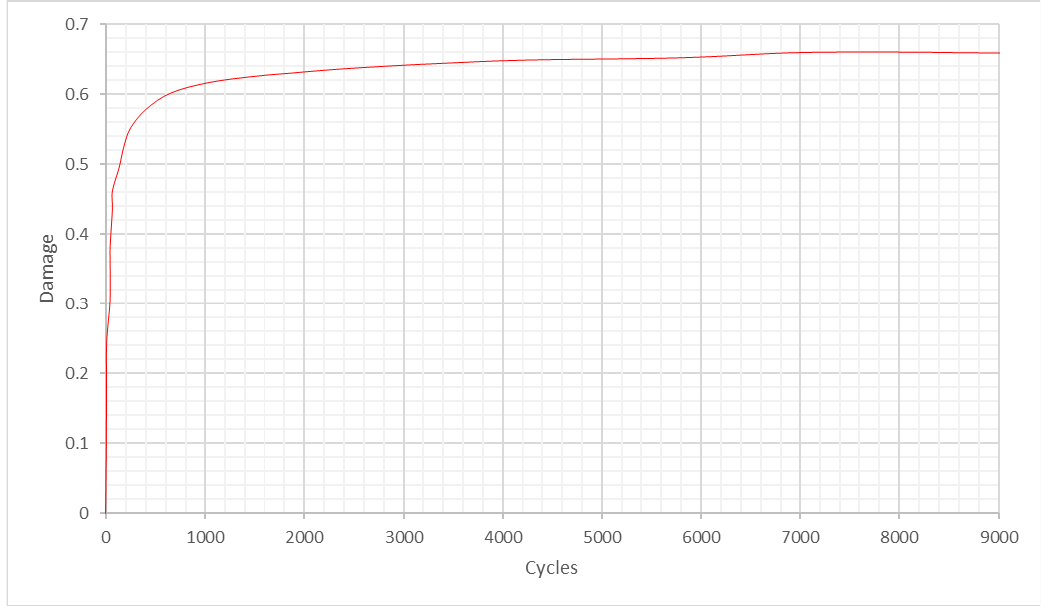
Figure 15. Damage versus fatigue cycles under the torsion scenario during cyclic loading.